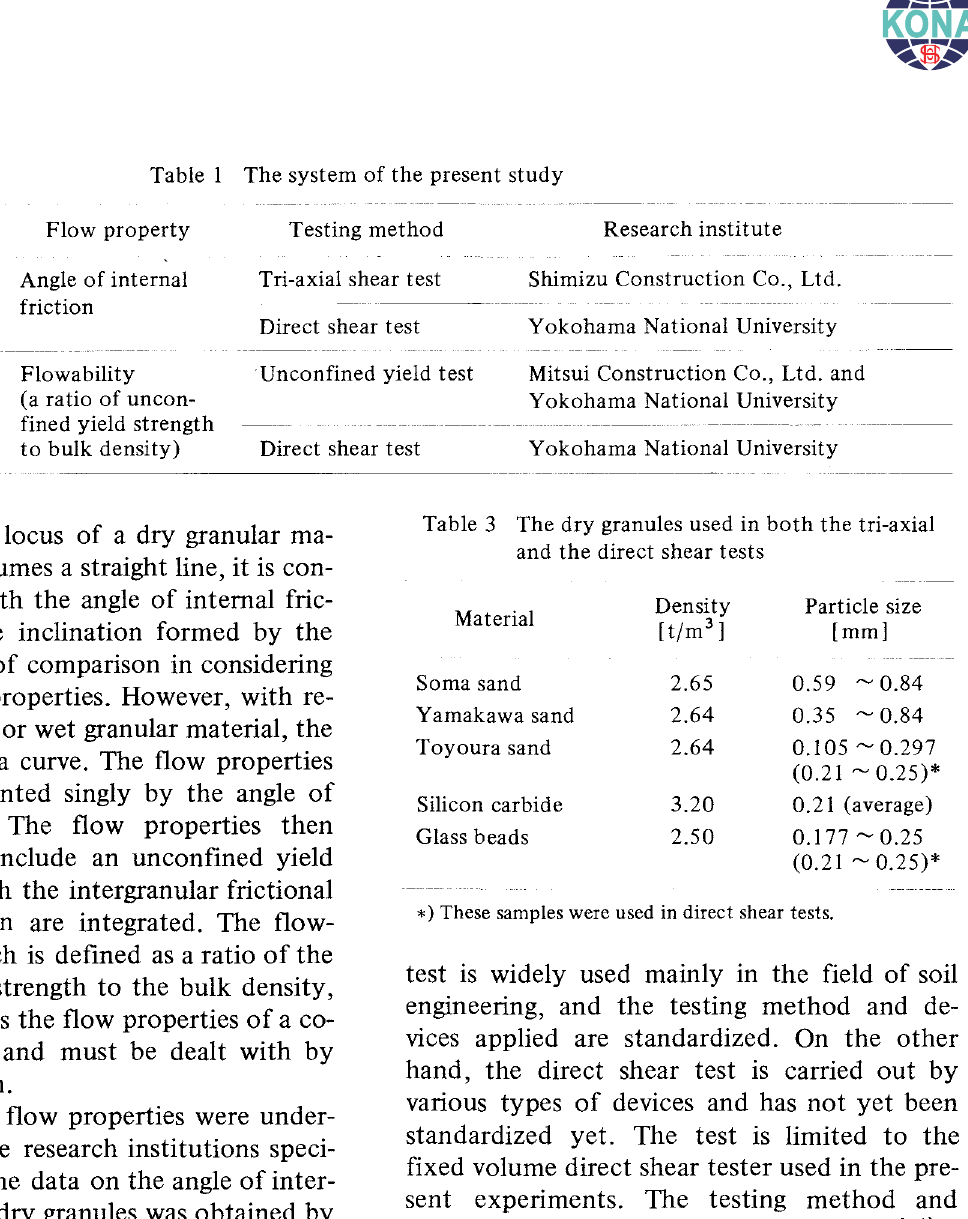
Table 2 The conditions of the experiment of the tri axial shear tests and the direct shear tests Condition